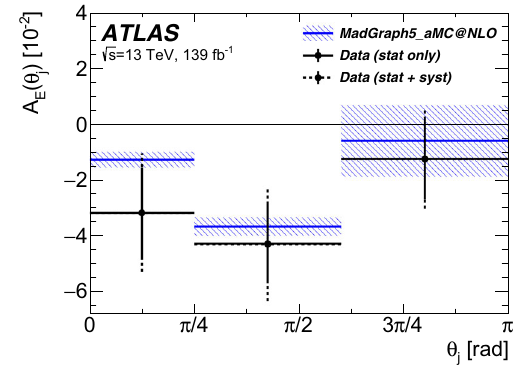
Fig. 7 Data measurements (black points with errors) and predictions (blue lines) of the energy asymmetry in three bins of the jet angle θ j . The SM prediction was obtained from simulations of t ¯ t j events with MadGraph5_aMC@NLO + Pythia8 at NLO in QCD for t ¯ t j + PS, including MC statistical and scale uncertainties (blue shaded bands) as described in Sect.